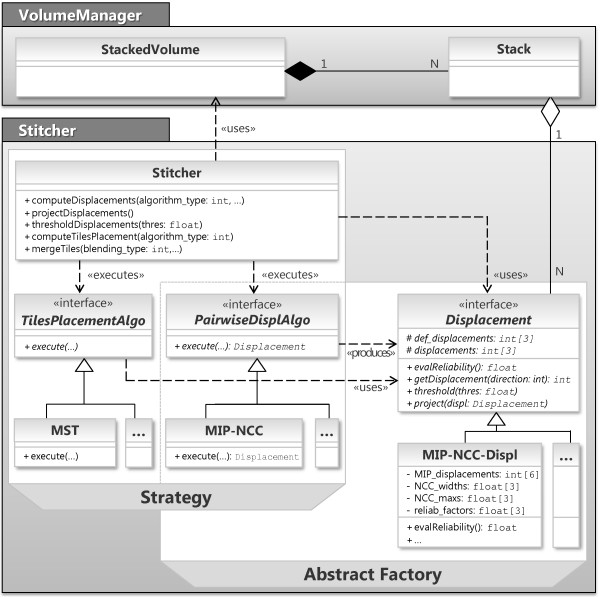
Class diagrams of VolumeManager and Stitcher modules. A StackedVolume contains as many Stack objects as the number of stacks that compose the volume and it is responsible to model data organization. The Stitcher methods implement the stitching pipeline and the strategies to use efficiently system resources, by accessing data through the StackedVolume. These strategies use the algorithms TilesPlacementAlgo and PairwiseDisplAlgo that may depend on the specific characteristics of images. Note that TilesPlacementAlgo uses Displacements produced by PairwiseDisplAlgo. Classes MST, MIP-NCC, and MIP-NCC-Displacement implement the actual algorithms used in our implementation.